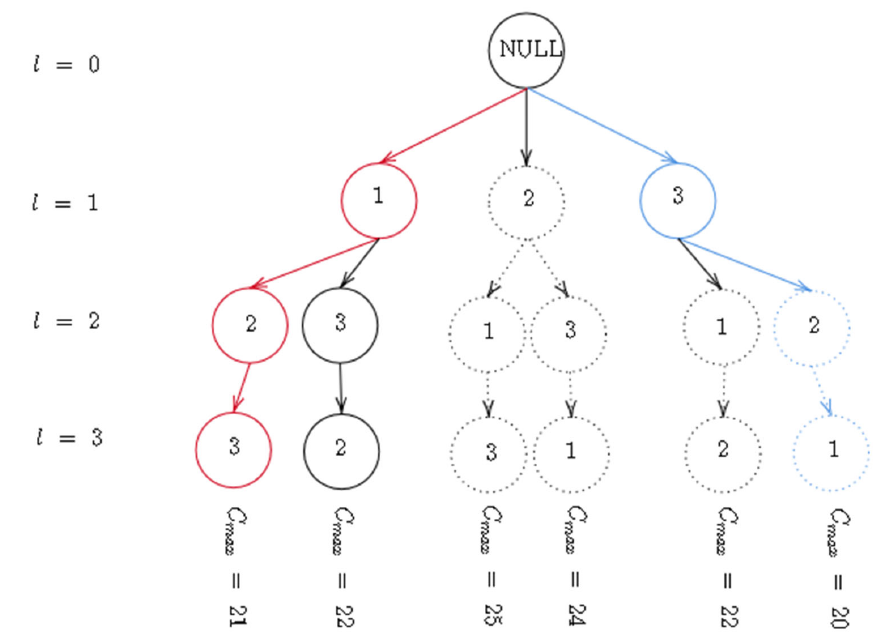
Fig. 3. Representation of BDP and its perspective as a heuristic procedure considering the criteria for space state reduc-